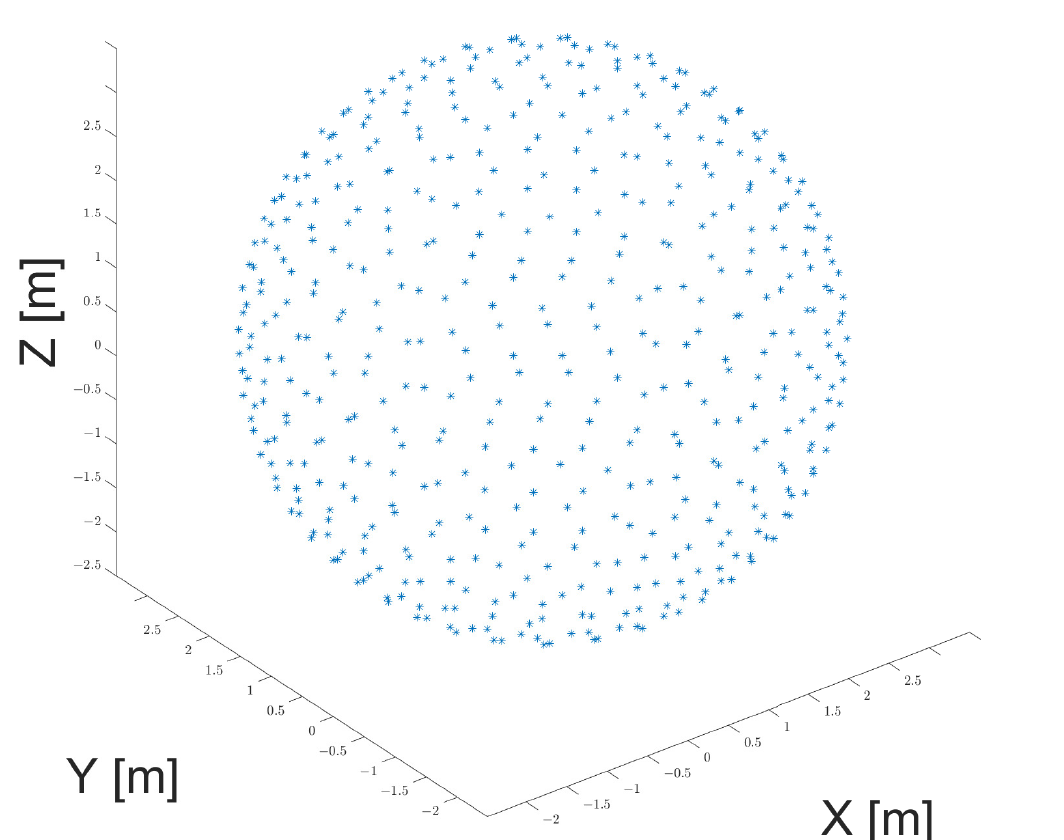
Figure 4. Receivers distribution.